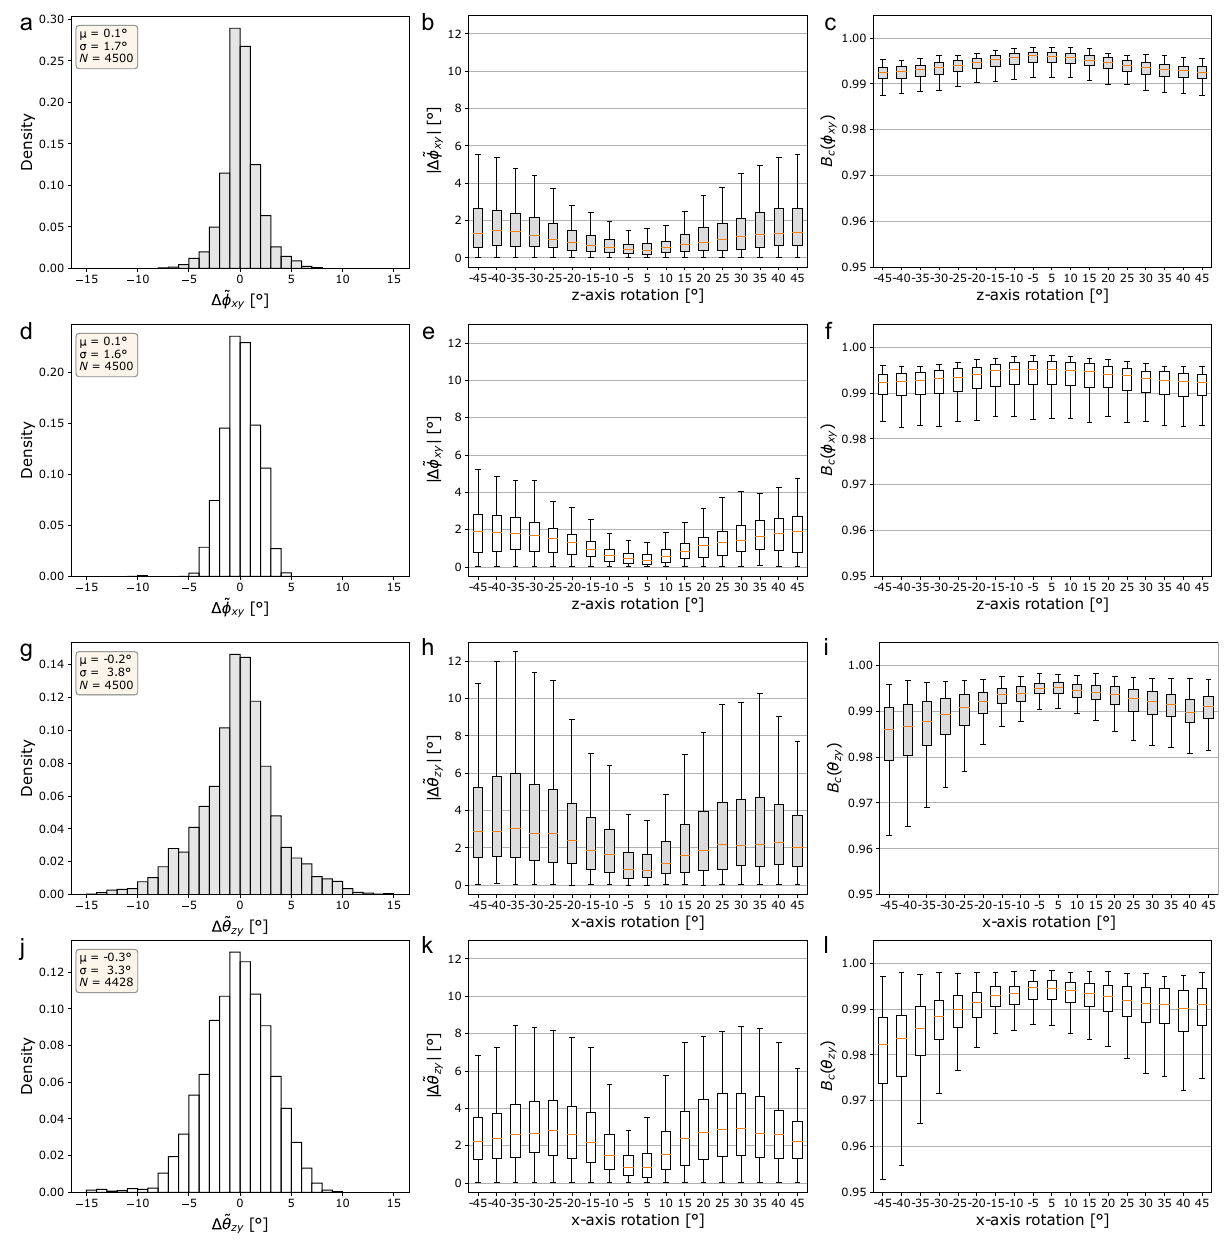
N TPFM N ROT , where Figure 2. Validation of the 3D Frangi-based fiber orientation maps accuracy ( N = × 18 is the number of test rotations). Left N TPFM denotes the total number of sample image patches, and N ROT = column: overall distributions of the inter-median errors; center column: absolute inter-median distances against the test rotation applied; right column: Bhattacharyya coefficient against test rotations. ( a – c ) Azimuth angle φ xy , grey matter images; ( d – f ) azimuth angle φ xy , white matter; ( g – i ) elevation angle θ zy , grey matter; ( j – l ) elevation angle θ zy , white orientation statistics of the selected WM image tiles, despite the random axis inversion preliminarily applied to the image patches considered in the present validation. On the other hand, consistently with the trend of the � φ xy inter-median distance , the estimated Bhattacharyya coefficients are remarkably uniform for the different ˜ | | planar rotations applied about the z-axis, with their median value never dropping below 0.99 in both the GM and WM image samples (Fig. 2c,f). Tables S1 and S2 in the Supplementary Information report the complete median values and interquartile ranges of the distributions shown in Fig. 2. Figure 3 summarizes the runtime performance of the Frangi-based fiber orientation analysis pipeline, applied to the TPFM reconstruction shown in Fig. 4. In detail, using Frangi filters with an increasing number of spatial scales determines an expected rise in the memory usage of the fiber orientation analysis stage (Fig. 3a). However, by parallelizing the estimation of the vesselness probability function (Eq. 9, Fig. 5), the interrogation of multiple scales does not lead to a proportional increase in the computational time of the filter. This accounts for a large